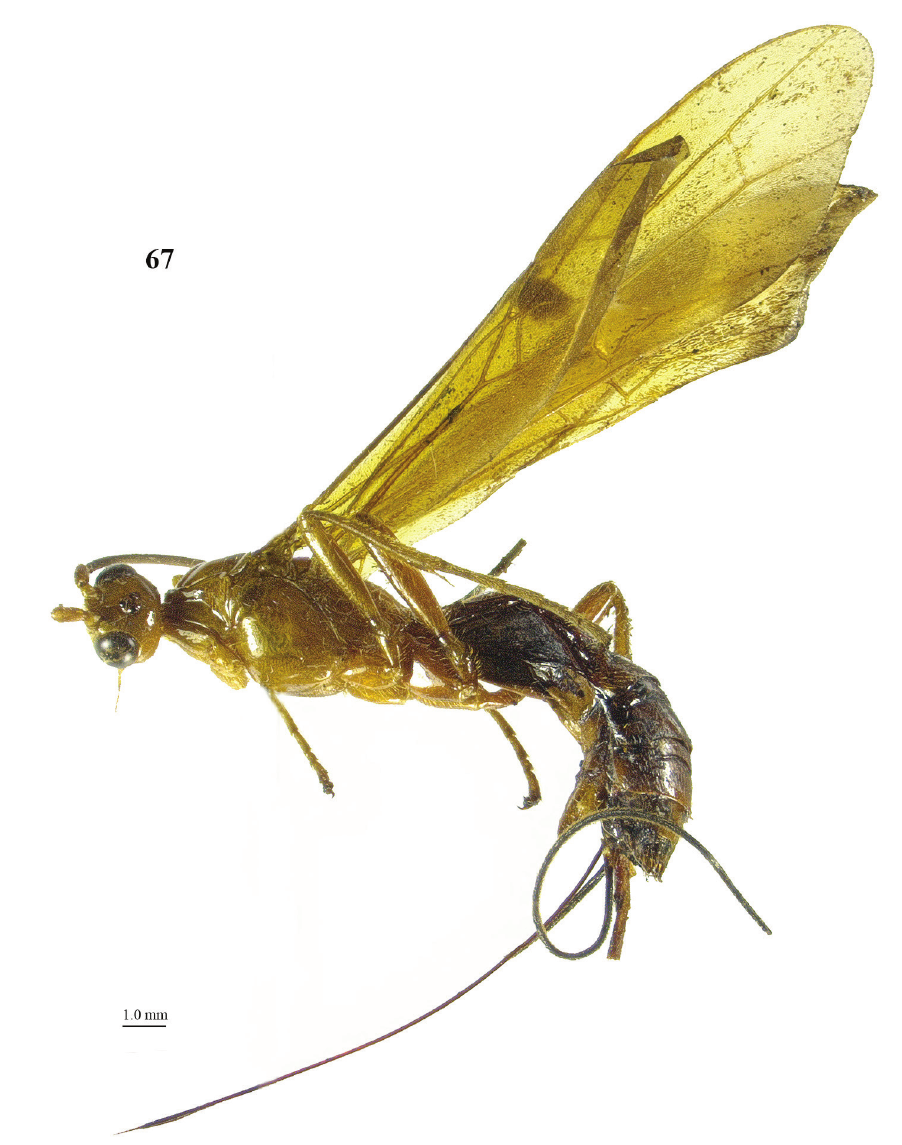
Figure 67. Maculibracon luteonervis sp. n., ♀ , holotype, habitus lateral. vertex smooth, with few long setae and shiny; stemmaticum distinctly protruding; OOL:diameter of posterior ocellus:POL = 24:9:8; in dorsal view length of eye 1.9 times temple; temples gradually roundly narrowed behind eyes, with some long setae, almost smooth dorsally and sparsely punctate ventrally (Figs 76, 77); malar suture shallow, curved; length of malar space 0.8 times basal width of mandible; mandible twisted, both teeth robust and